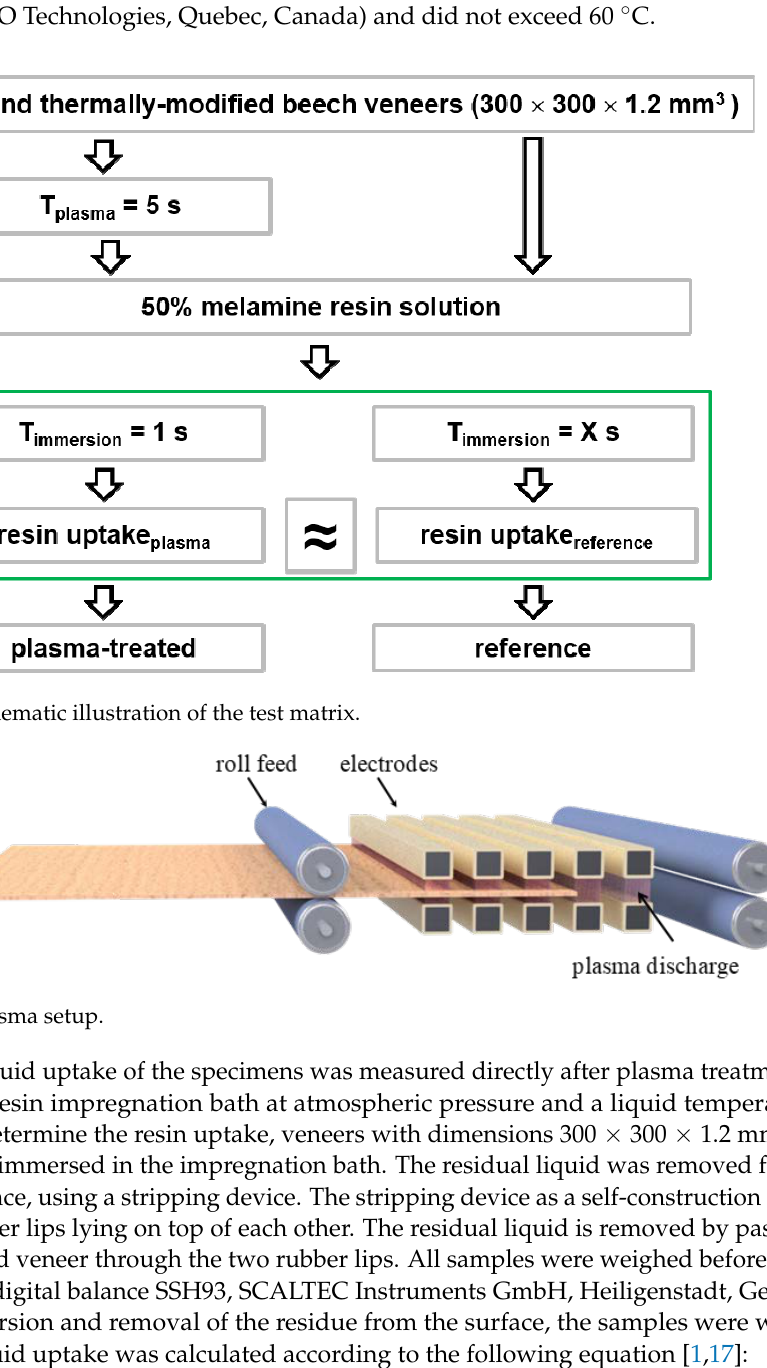
Figure 1. Schematic illustration of the test matrix.